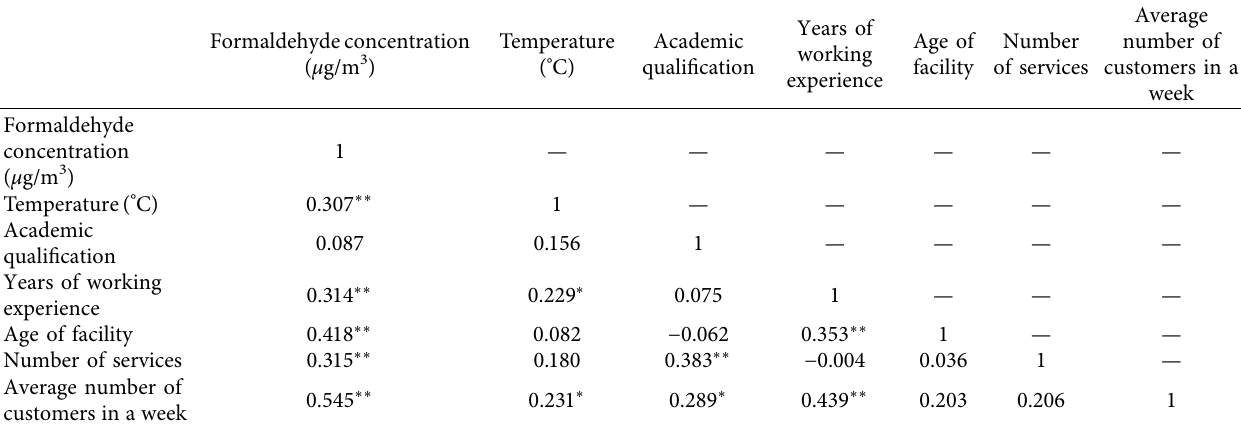
Table 3: Correlation between dependent variables and independent